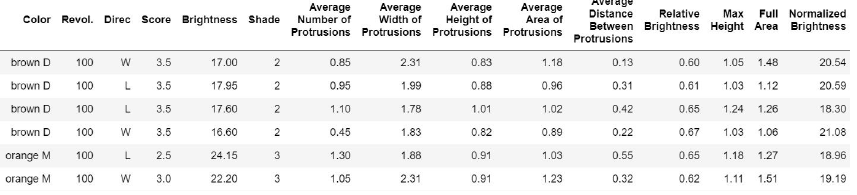
Figure 4. A sample of the cleaned dataset.